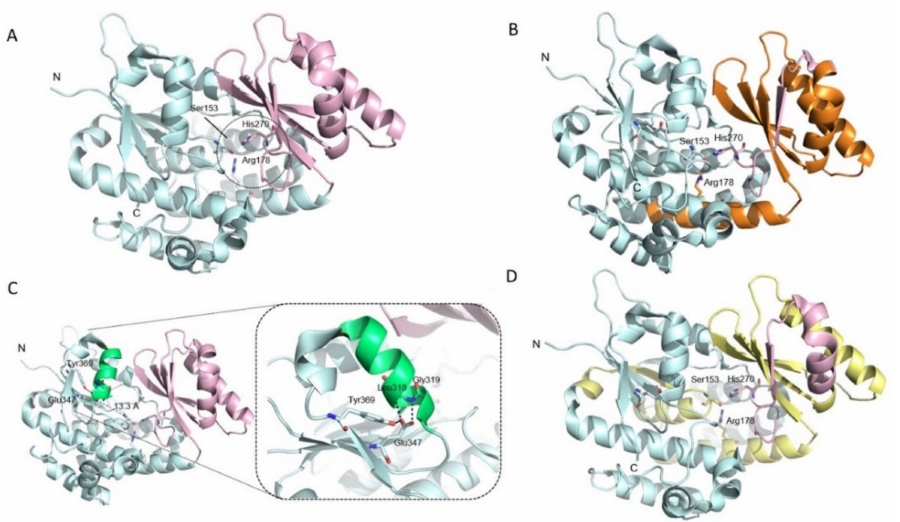
Figure 2. Structure of human MCAT isoforms and mutant products. The MCAT structure cartoon was prepared with Protein Data Bank (PDB) coordinates for 2C2N (https://www.rcsb.org/) using the PyMOL molecular visualization system, version 1.7.4.0 (Schrödinger, LLC, New York, NY, USA). ( A ) The full-length protein is composed of a large domain (cyan) and a smaller one (pink). The active-site residues, Ser153, His270, and Arg178, are shown in a gorge between the two subdomains. ( B ) The protein isoform lacking the amino acid sequence encoded by exon 3 (orange) lacks most of the smaller domain and Arg178, and it is likely inactive. ( C ) A full and zoom view of Glu347 in the structure. Glu347 is 13.3 Å away from the active-site Ser153. It interacts electrostatically with the side chain of Tyr369 and the backbone amides of Leu318 and Gly319, stabilizing a helix formed by Arg352–Cys361 (green) at the interface between the two domains. ( D ) The isoform missing residues 142 to 243 (yellow) lacks almost all of the smaller domain, the active-site residues Ser153 and Arg178, and elements of the secondary structure important to the activity of the